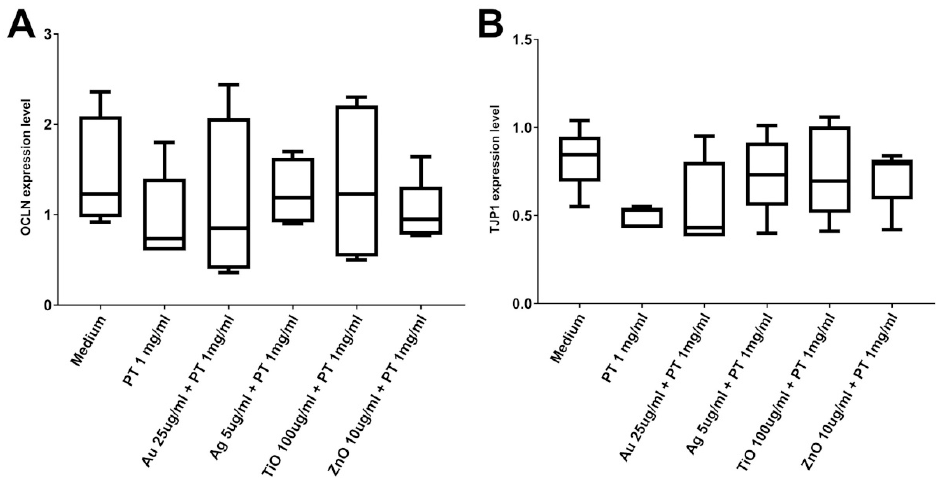
Figure 5. Tight Junction components mRNA expression in post-confluent Caco2 cells. ( A ) Occludin (OCLN gene) mRNA expression. ( B ) Zonula Occludens-1 (TJP1 gene) mRNA expression. Box plots represent median, 25th, and 75th percentiles. Whiskers indicate 5th and 95th percentiles.